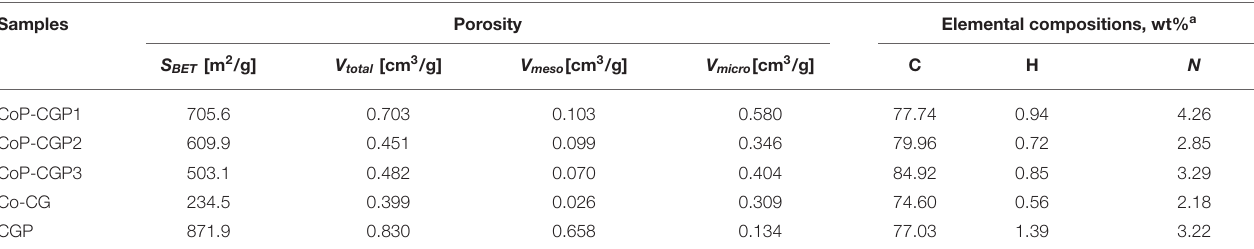
TABLE 1 | Textural properties and elemental compositions of various catalysts. Samples